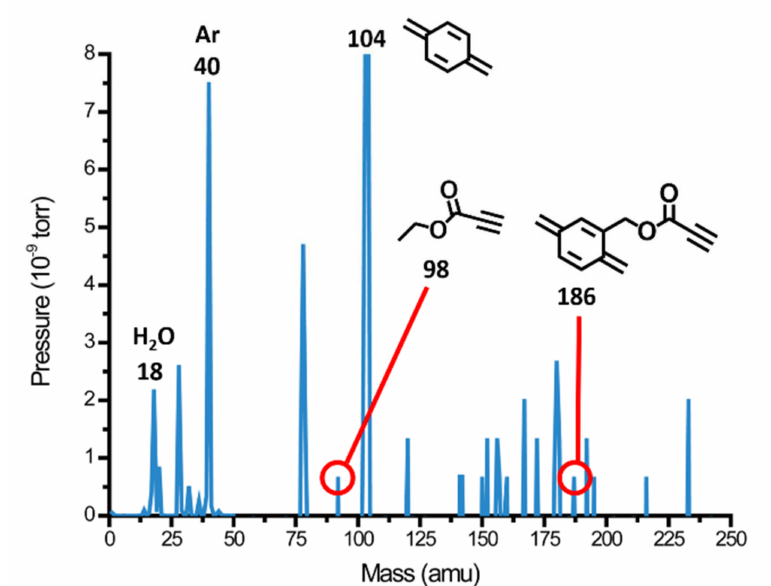
Figure 2. Analysis of vapor compositions during the vapor sublimation and deposition fabrication process. The residual gas analyzer (RGA) results showed the expected presence of sublimating water molecules at 18 amu and the depositing molecules that were composed of methyl propiolate at 98 amu, quinodimethane at 104 amu, and methyl propiolate-substituted quinodimethane at 186 amu. The carrier gas of argon at 40 amu was also detected.